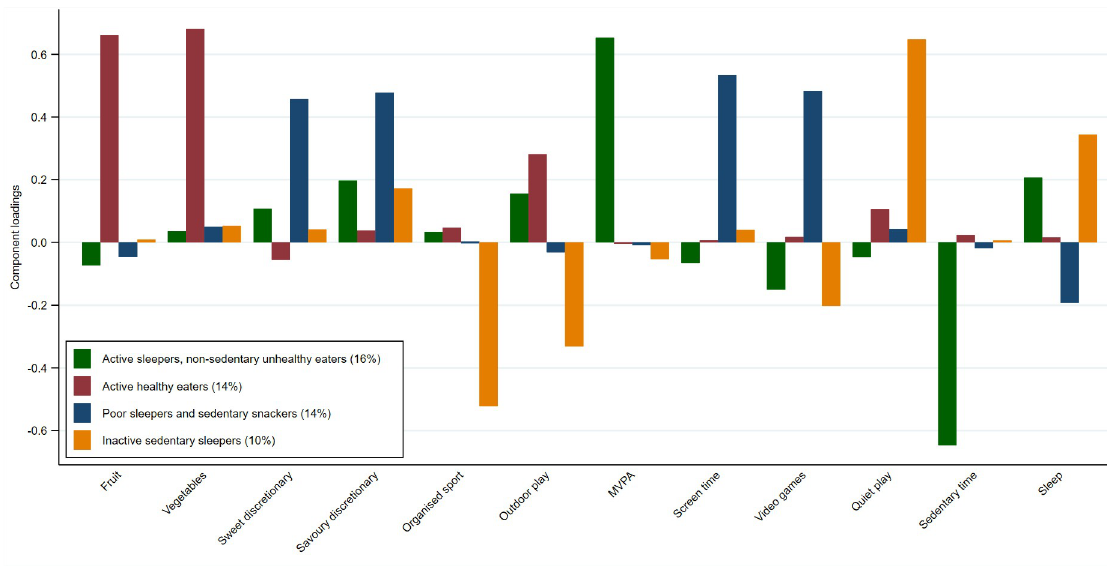
Fig 3. Component loadings for each behavioural pattern derived using principal component analysis. Footnote: The percentage after each pattern label is the percent of the total data variance explained by that pattern.